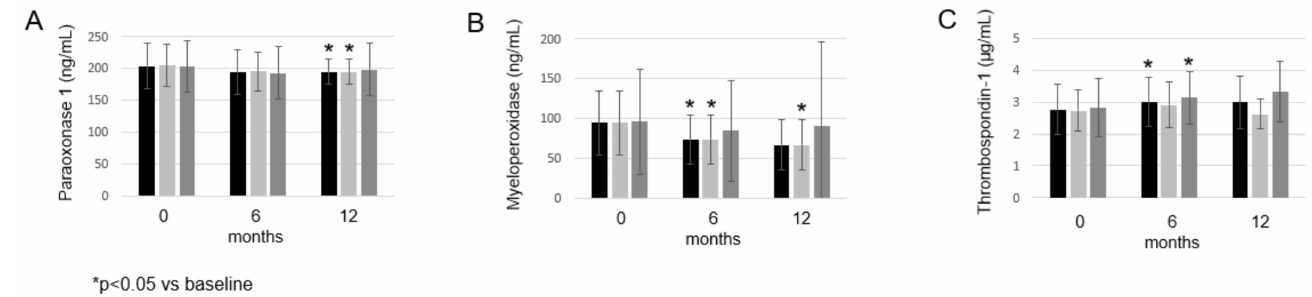
Figure 3. Effects of one-year tofacitinib therapy paraoxonase 1 ( A ), myeloperoxidase ( B ) and thrombospondin-1 ( C ) levels in the entire RA cohort, 5 mg bid and 10 mg bid treatment arm, respectively, at baseline, and 6 and 12 months of treatment. Asterisks indicate significant changes ( p <